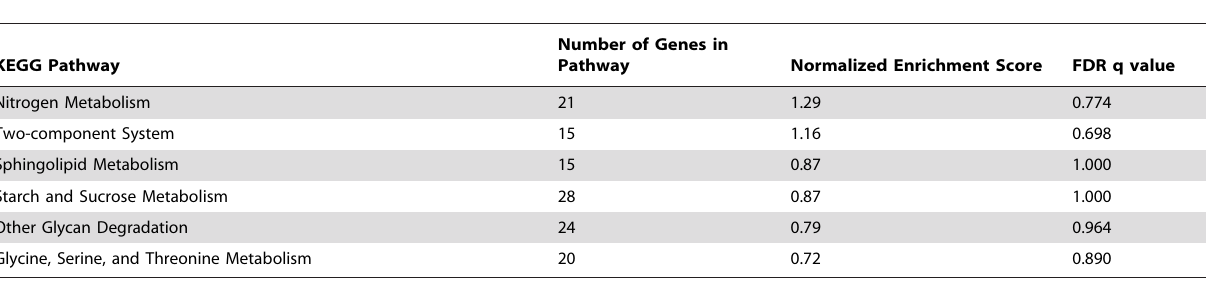
Table 4. KEGG Canonical Pathways that are Enriched with Genes Upregulated in B. theta from Monoassociated HLA-B27 Tg Rats.